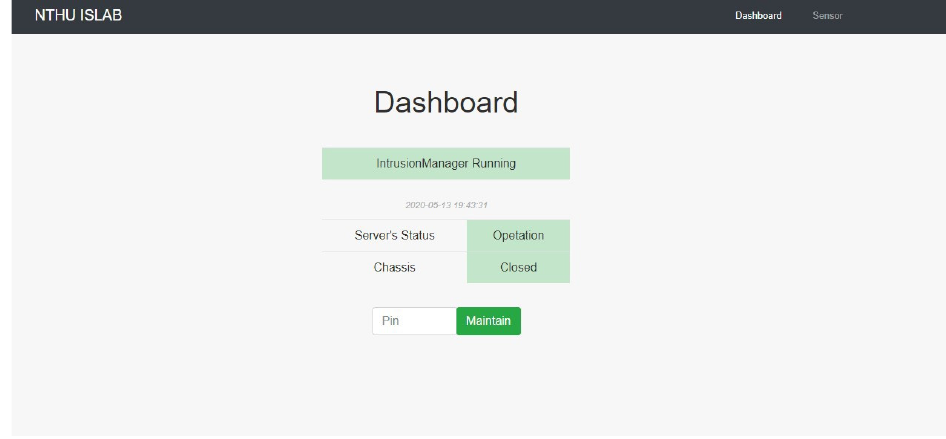
Figure 19. PSPS IDSWeb.